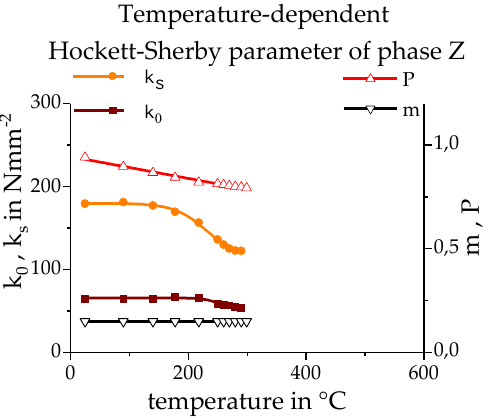
Figure 13. Experimentally obtained flow curves of alloy EN AW-6060 T4 at different temperatures during cooling after a 250 °C maximum temperature (phase Z).